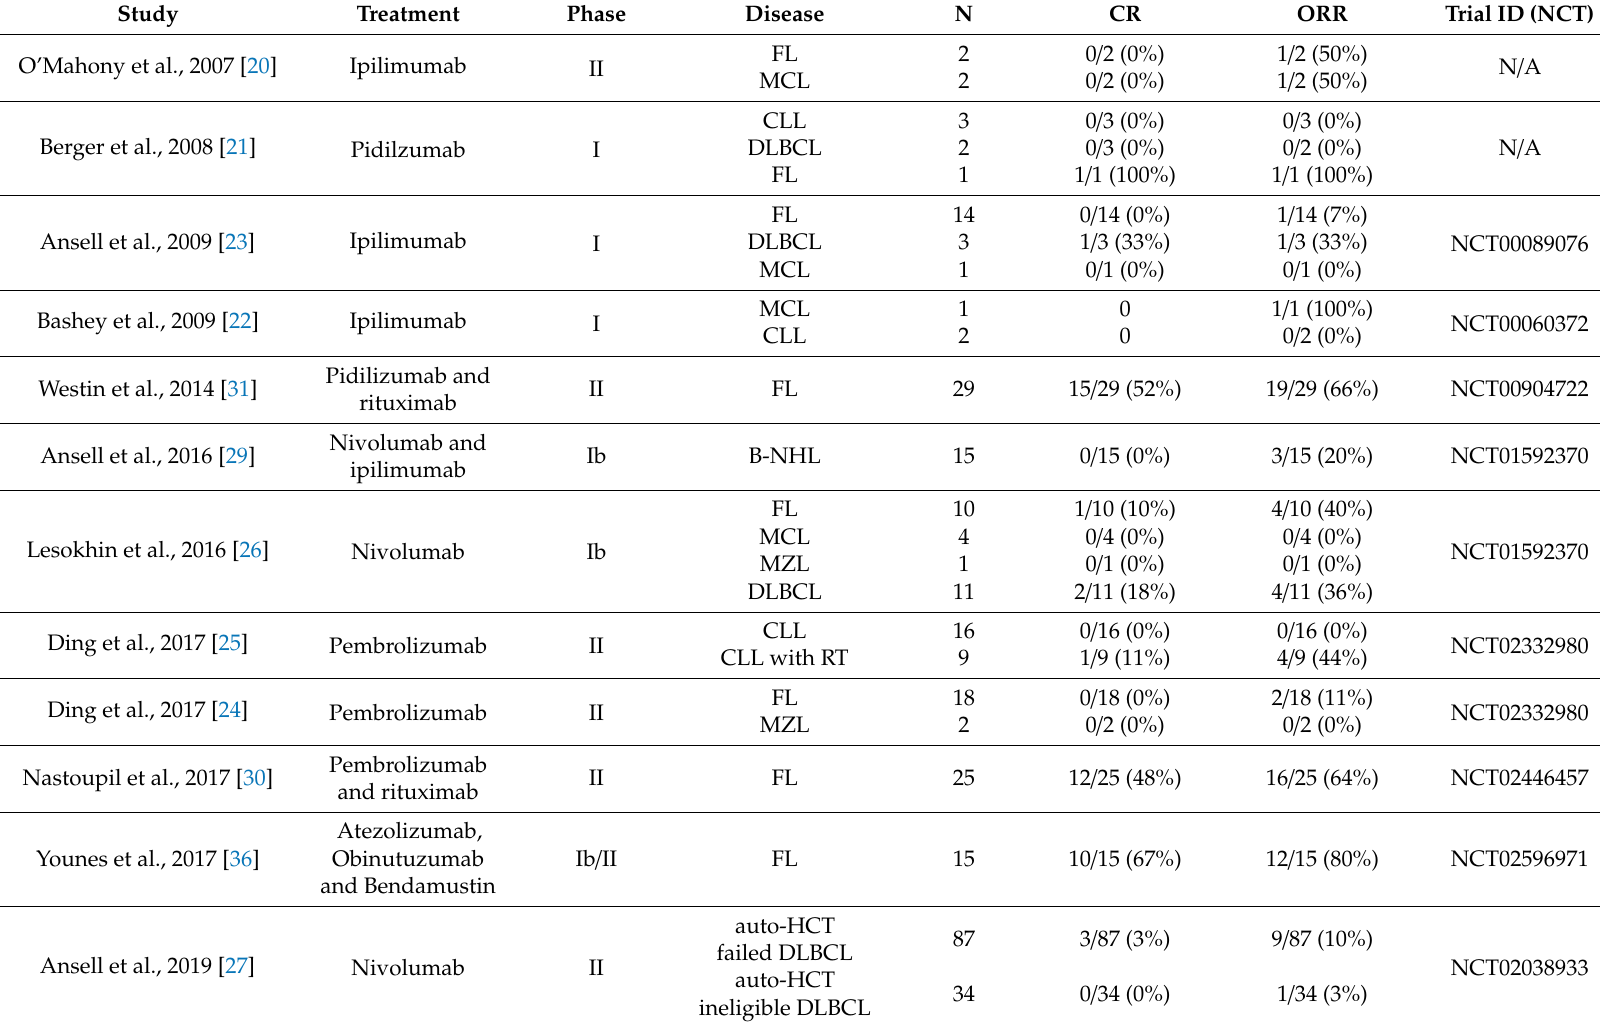
Table 1. Reported studies of immune checkpoint blockade in B-cell non-Hodgkin lymphoma